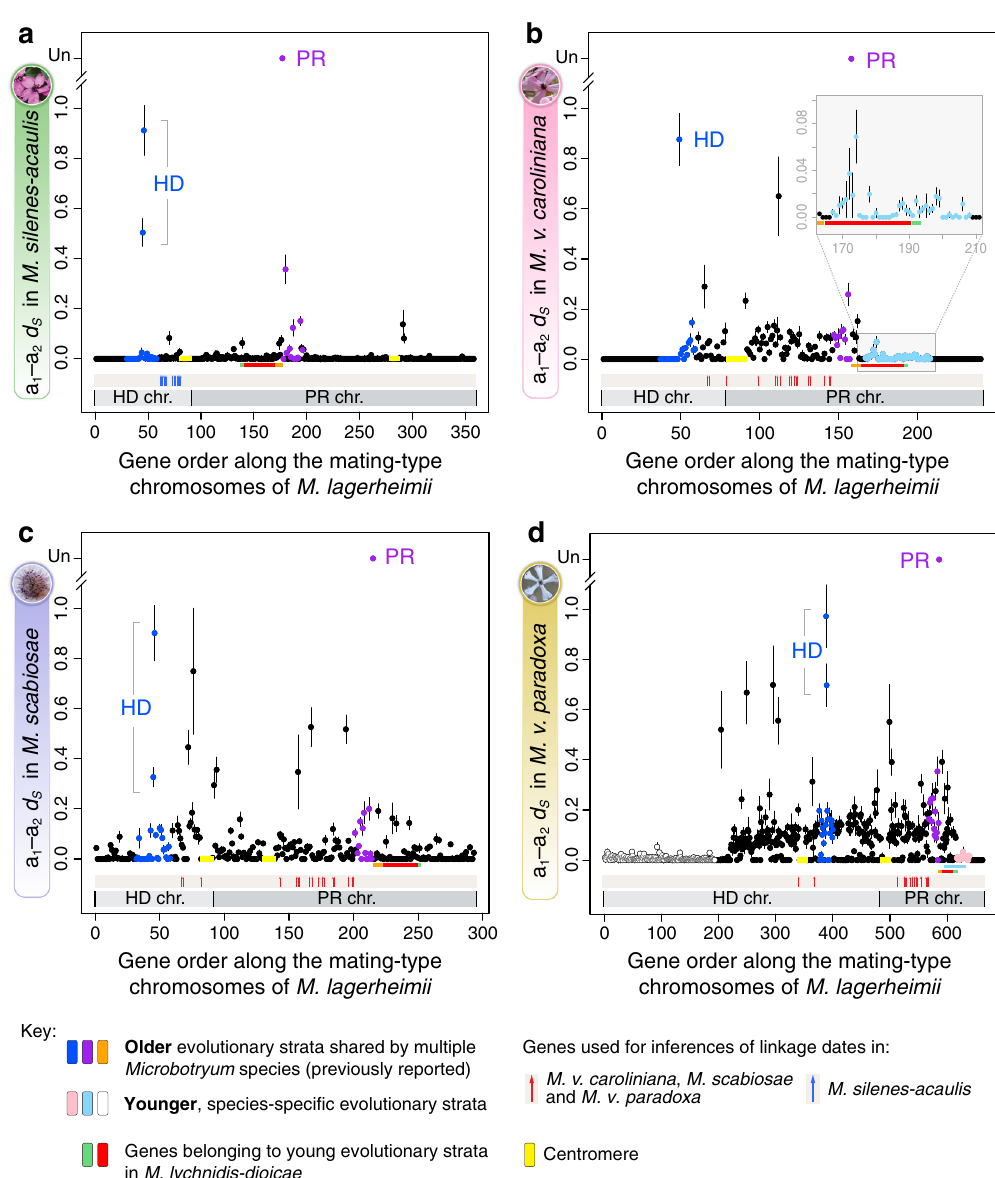
Fig. 3 Divergence between a 1 - and a 2 -associated alleles. Per-gene synonymous divergence and standard error ( d S ± SE) between alleles associated with the a 1 and a 2 mating types within Microbotryum diploid individuals, following the ancestral gene order for the mating-type chromosome. Synonymous divergence is plotted against the genomic coordinates of the a 1 mating-type chromosomes of M. lagerheimii for all single-copy genes common to both mating-type chromosomes. The limits of the PR and HD M. lagerheimii mating-type chromosomes are indicated and oriented according to the fusion in each species (i.e., not in the same orientation in all species). Divergence between the a 1 and a 2 pheromone receptor (PR) genes was too extensive and d S could not be calculated (depicted as “ Un ” for unalignable). The yellow boxes indicate the positions of M. lagerheimii putative centromeres. The red vertical arrows at the bottom indicate the 17 genes used for inferring HD – PR linkage dates in all species except for M. silenes-acaulis , for which we used a restricted set of 13 genes ancestrally located between the HD locus and the putative centromere (blue vertical arrows). Ancient evolutionary strata that evolved at the base of the Microbotryum clade are indicated in purple (around PR) and blue (around HD), as in the previous study in which they were discovered 16 . The genes involved in the more recent evolutionary strata previously identi fi ed in M. lychnidis-dioicae 16 are indicated with red and green bars at the bottom. a M. silenes-acaulis ; b M. v. caroliniana , with a recent stratum indicated in light blue and enlarged in an inset; the current location of these genes is indicated in Supplementary Fig. 6a; c M. scabiosae ; d M. v. paradoxa , with recent strata depicted in pink and white (the current location of these genes is indicated in Supplementary Fig. 8a). The light blue bar at the bottom indicates the genes involved in the young evolutionary stratum of M. v. caroliniana